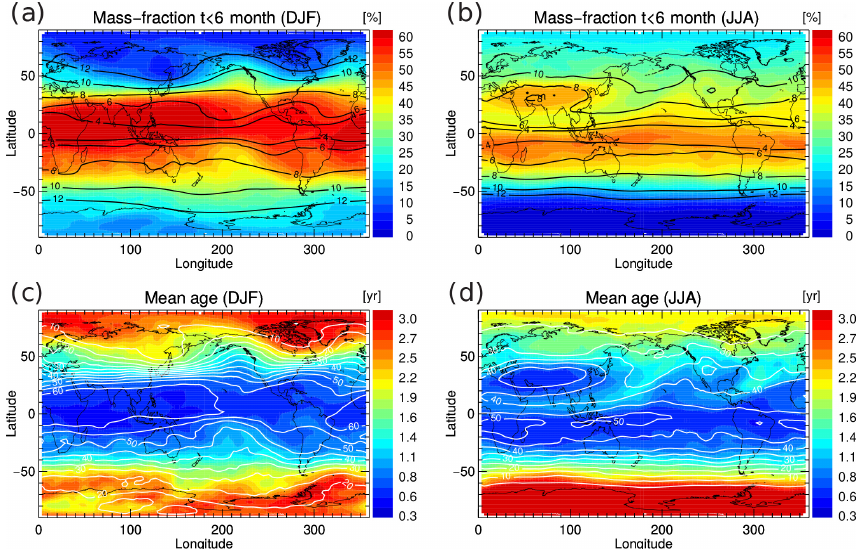
Figure 8. Fresh air fraction F 6 (transit time below 6 months) at 400K during (a) December–February, and (b) June–August. Black contours show potential vorticity from ERA-Interim ( ± 4, ± 6, ± 8, ± 10, ± 12PVU). (c) Mean age at 400K during December–February, and (d) June– August (white contours illustrate the fresh air fractions from a , b